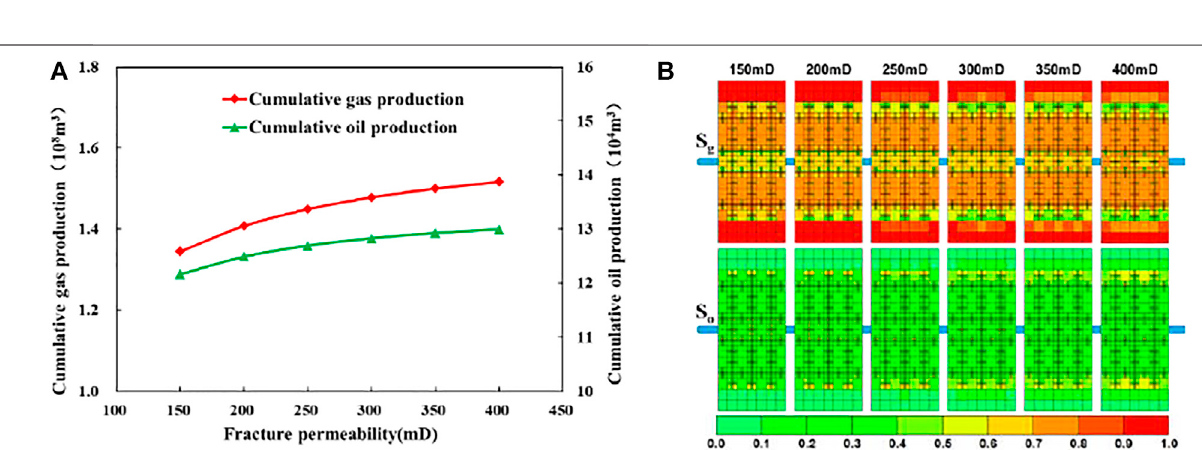
Frontiers in Earth Science |